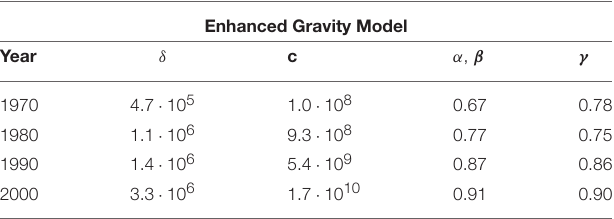
TABLE 2 | Parameter values for the Enhanced Gravity Model calculated by considering integer link weights (equal to integer multiples of the monetary unit used in the dataset) and carrying out the corresponding ML estimation as prescribed by Equations (23) and